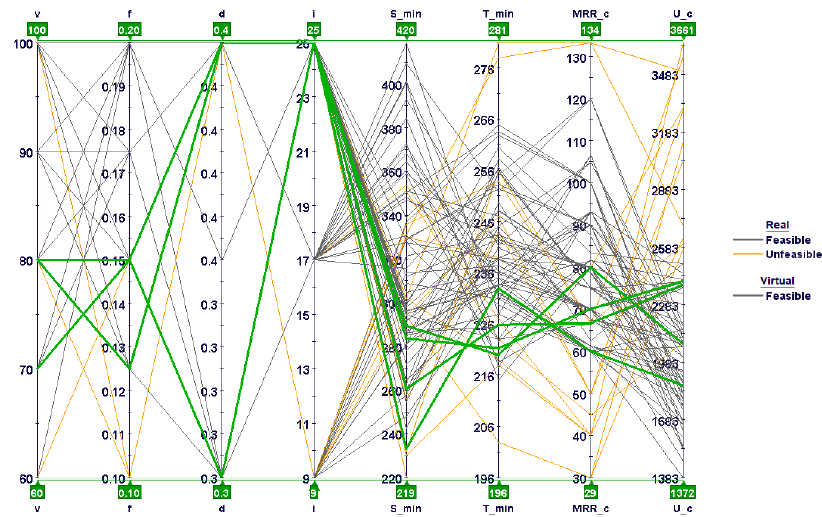
Figure 14. Parallel coordinate charts showing all design variables.